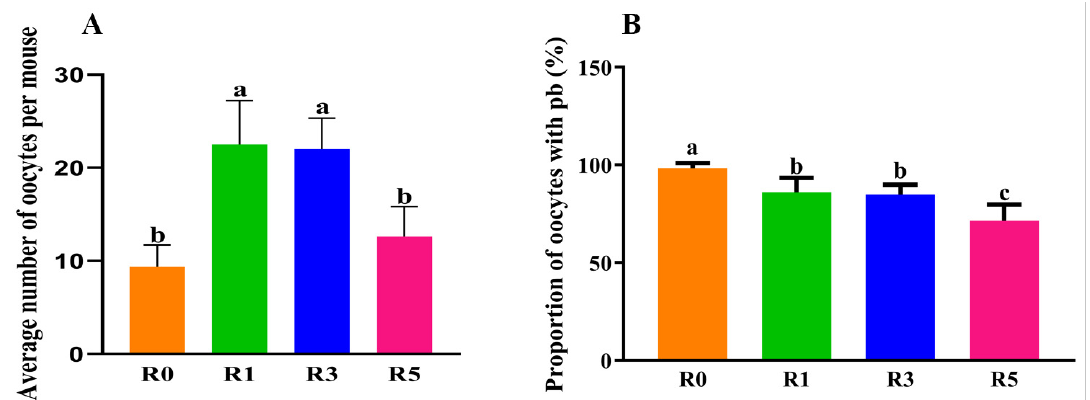
Figure 1. Repeated superovulation changed oocyte number. ( A ), with the increase in superovulation time, the average number of ovulated oocytes was decreased; each dot represents the average oocytes per mouse in each repeated experiment; ( B ), the ratio of oocytes with 1st polar body was also analyzed; each dot represents the pb proportion of ovulated oocytes in each repeated experiment. Repeated superovulation reduced ratio of mature oocytes. The same letters mean the statistical difference was not significant between groups ( p > 0.05, unpaired t -test); different letters mean the statistical difference was significant between groups ( p < 0.05, unpaired t -test).